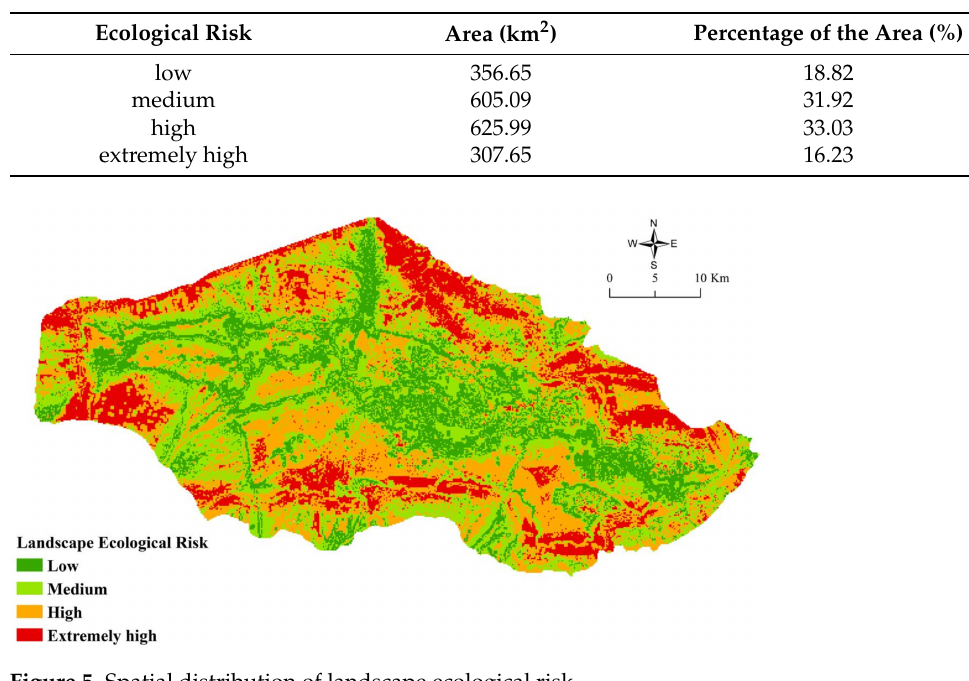
Figure 5. Spatial distribution of landscape ecological risk.